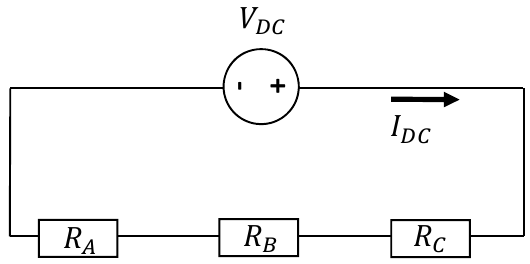
Figure 25. Equivalent circuit for thermal testing of the HM3D machine.